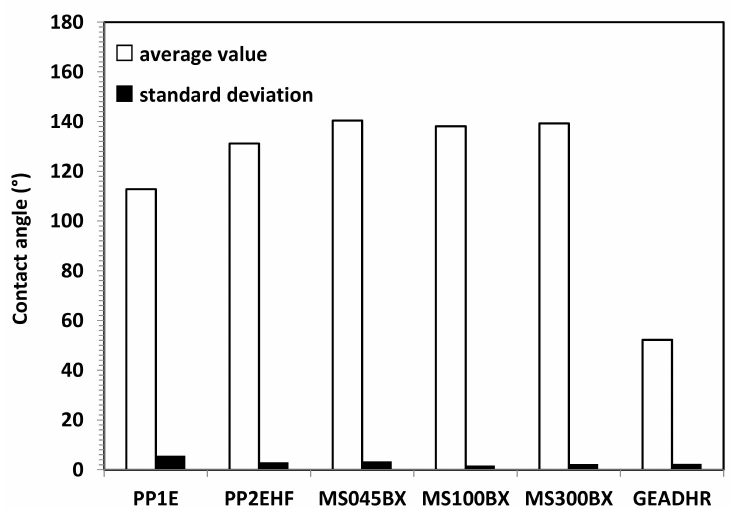
Figure 6. Average CA value and SD for VMD (PP and PTFE MS) and RO (GEADHR)